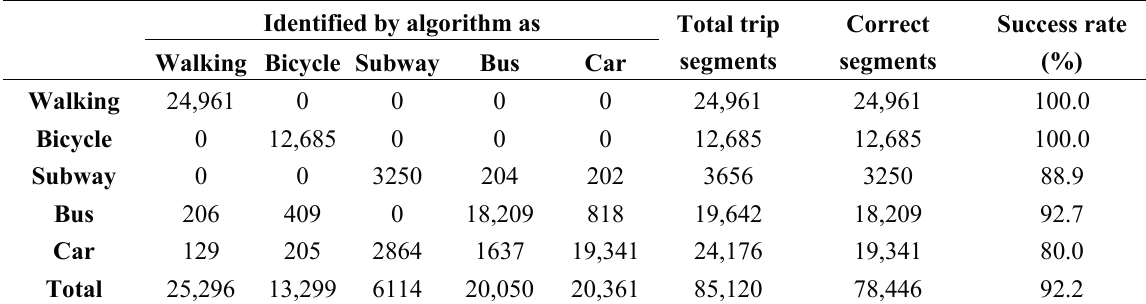
Table 8. Verification results of the mode detection